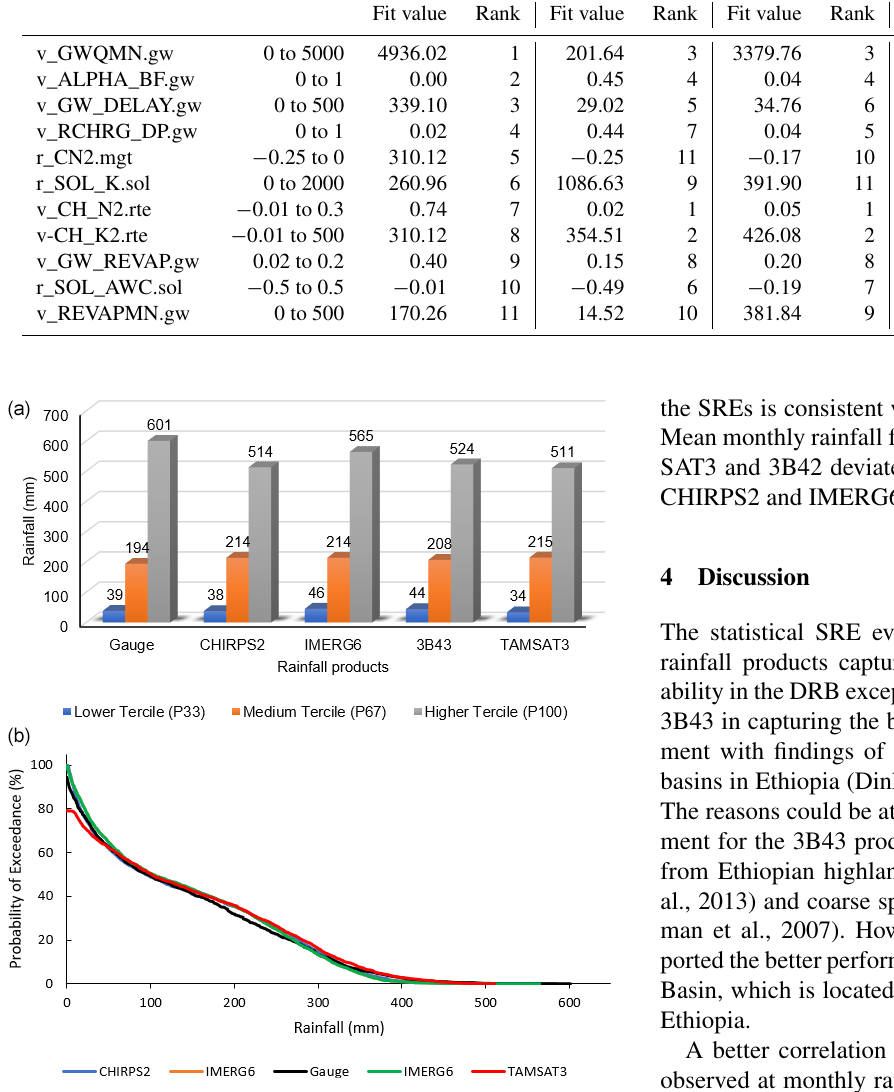
Figure 6. Tercile categories (a) and probability of exceedance of SREs (b)